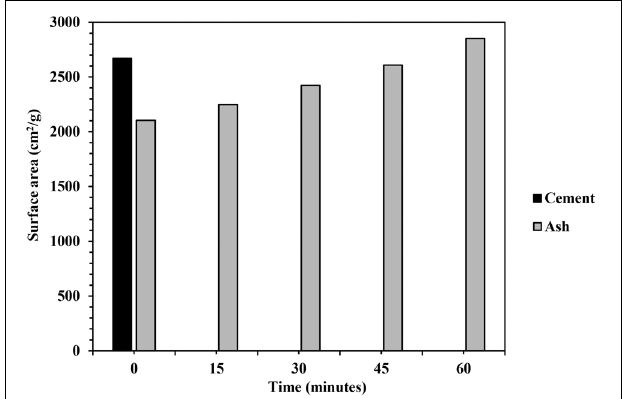
FIGURE 3 | Influence of grinding duration on the surface area of bagasse ash and its comparison with